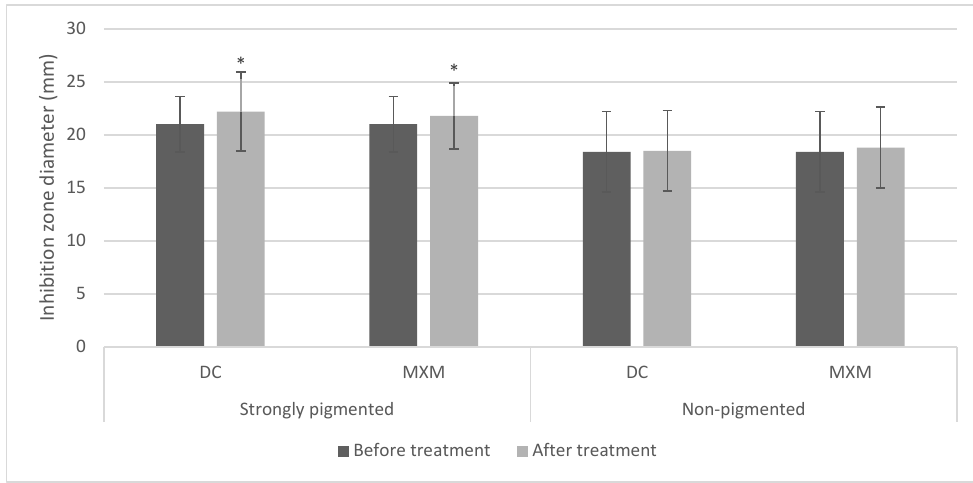
Figure 7. Bar chart representing mean and standard deviation values for inhibition zones of nuclease activity. Asterisks indicate statistical significance at p ≤ 0.05.